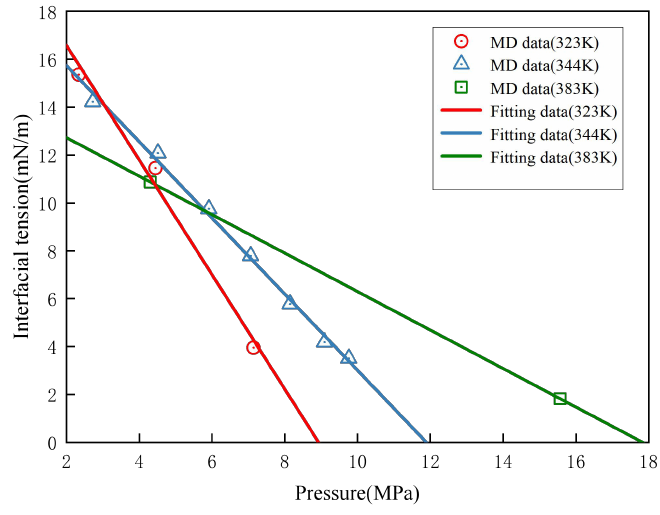
Figure 7 — Effect of temperature on MMPs.